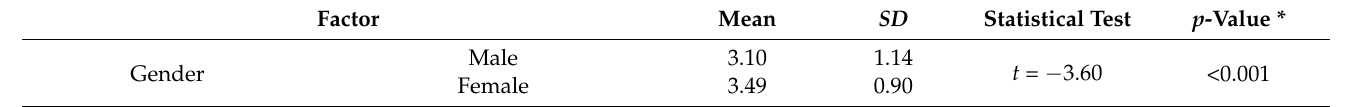
Table 3. Results of the association between Quality Improvement Nursing Attitudes and